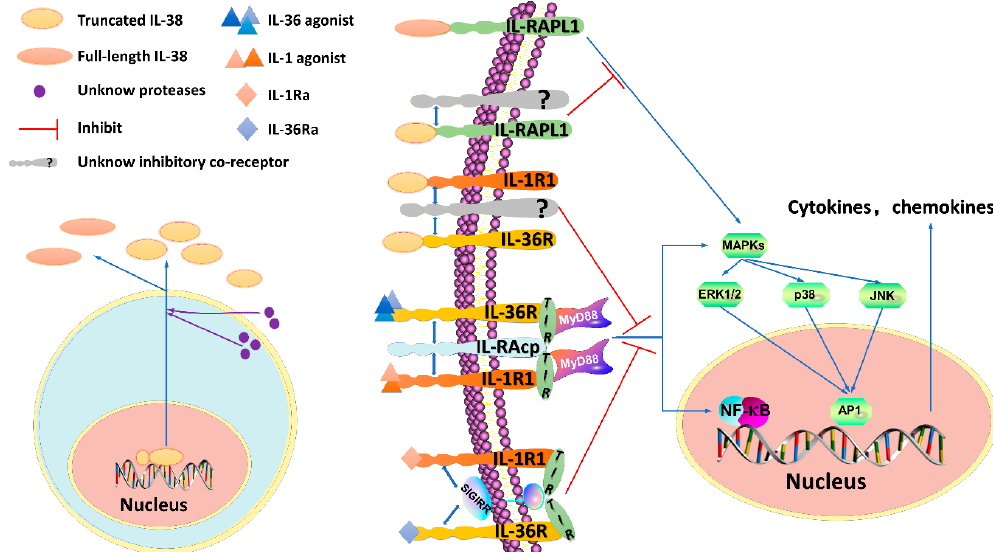
Figure 1. IL-38 signaling pathways. The N-terminus of IL-38 requires cleavage, but which protease(s) is responsible remains unknown. The process may involve an intra- or extracellular protease(s). IL-38 is mainly reported to exist in two forms—a truncated form and a full-length form. However, which form(s) of IL-38 is naturally present in the human body remains unknown. Interleukin-1 receptor 1 (IL-1R1) and IL-36R are activated by the agonists IL-1 and IL-36, respectively. The heterodimeric receptor complex consisting of IL-1R1 or IL-36R and interleukin-1 receptor accessory protein (IL- 1RAcP) results in myeloid differentiation primary response 88 (MyD88) recruitment through the intracellular toll-interleukin 1 receptor (TIR) domain, and the downstream signaling pathways that are activated include (A) the nuclear factor kappa B (NF- κ B) pathway and (B) the mitogen-activated protein kinase (MAPK) pathway through extracellular regulated protein kinases (ERK), p38 or c-Jun